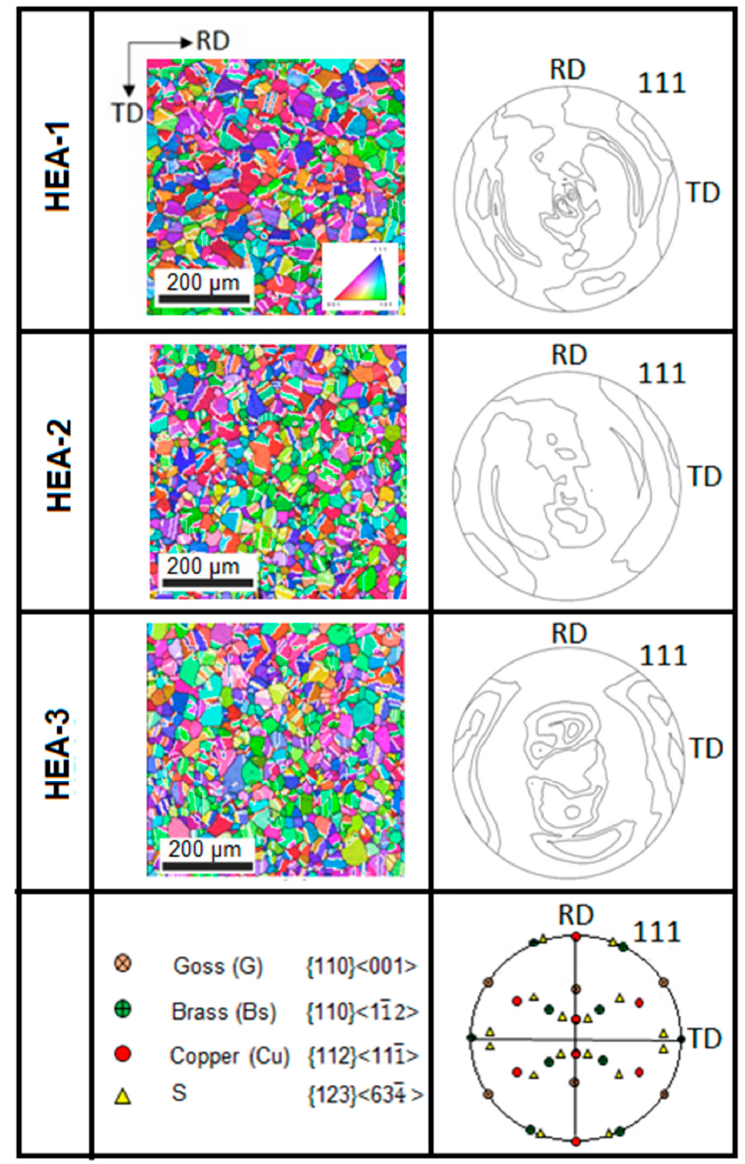
Figure 2. Microstructure and texture of starting HEAs 1–3 represented by inverse pole figure (IPF) maps (black lines: high angle grain boundaries; white lines: Σ 3 twin boundaries; color coding of the normal direction) and (111) pole figures (intensities are given in multiples of a random distribution: 1.0, 1.2, 1.5, 1.7, 2.0. RD = rolling direction; TD = transverse direction). The lower pole figure gives the position of the main rolling texture components {hkl} <uvw> ({rolling plane} <rolling direction>) of the FCC metals and alloys.